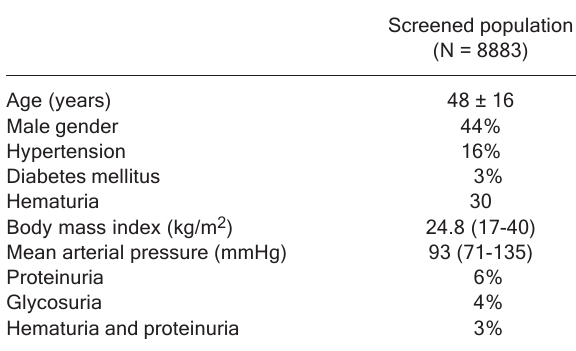
Table 1. Clinical characteristics and urine abnormalities of the screened population.